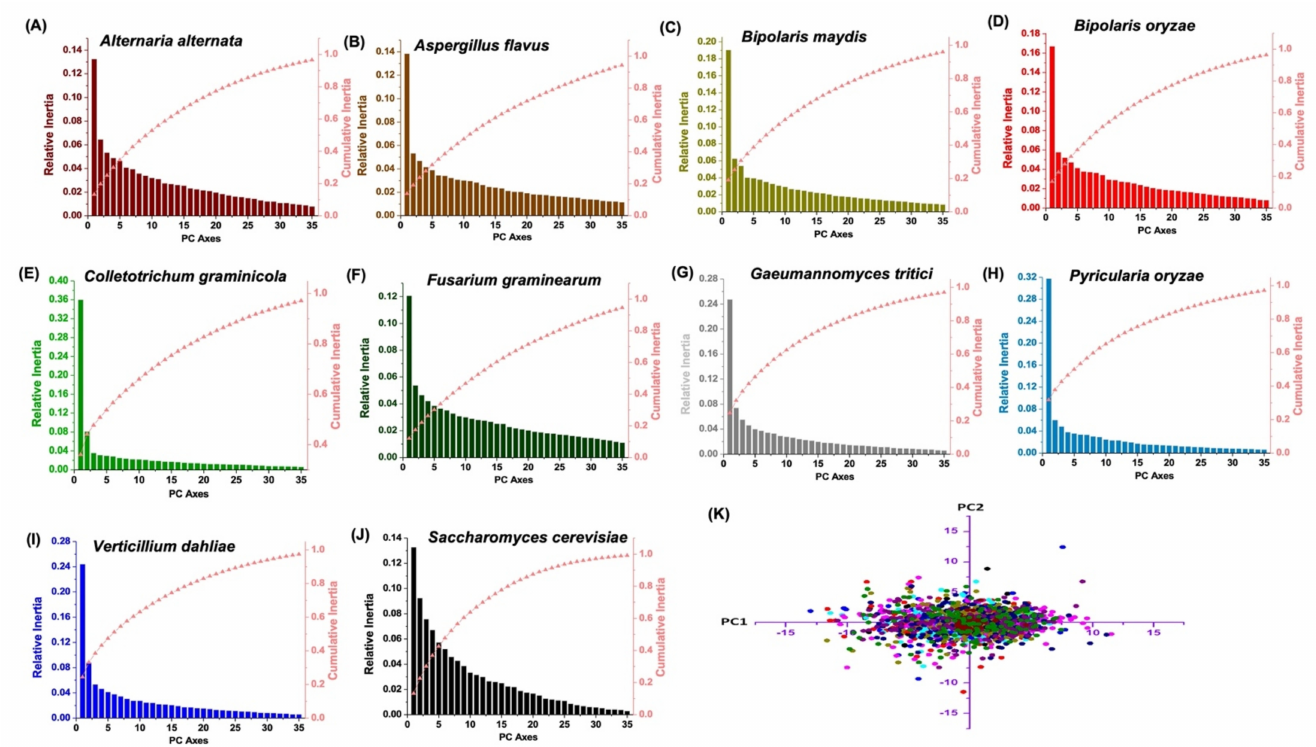
Figure 7. The principal component analyses of RSCU values of zinc binuclear cluster family coding sequences. ( A – J ) Inertia value of the axes obtained from the PCA analysis of the RSCU values for zinc binuclear cluster family coding sequences from the ten target species under study: ( K ) Plotting the principal axes values explaining maximum variances from all the ten